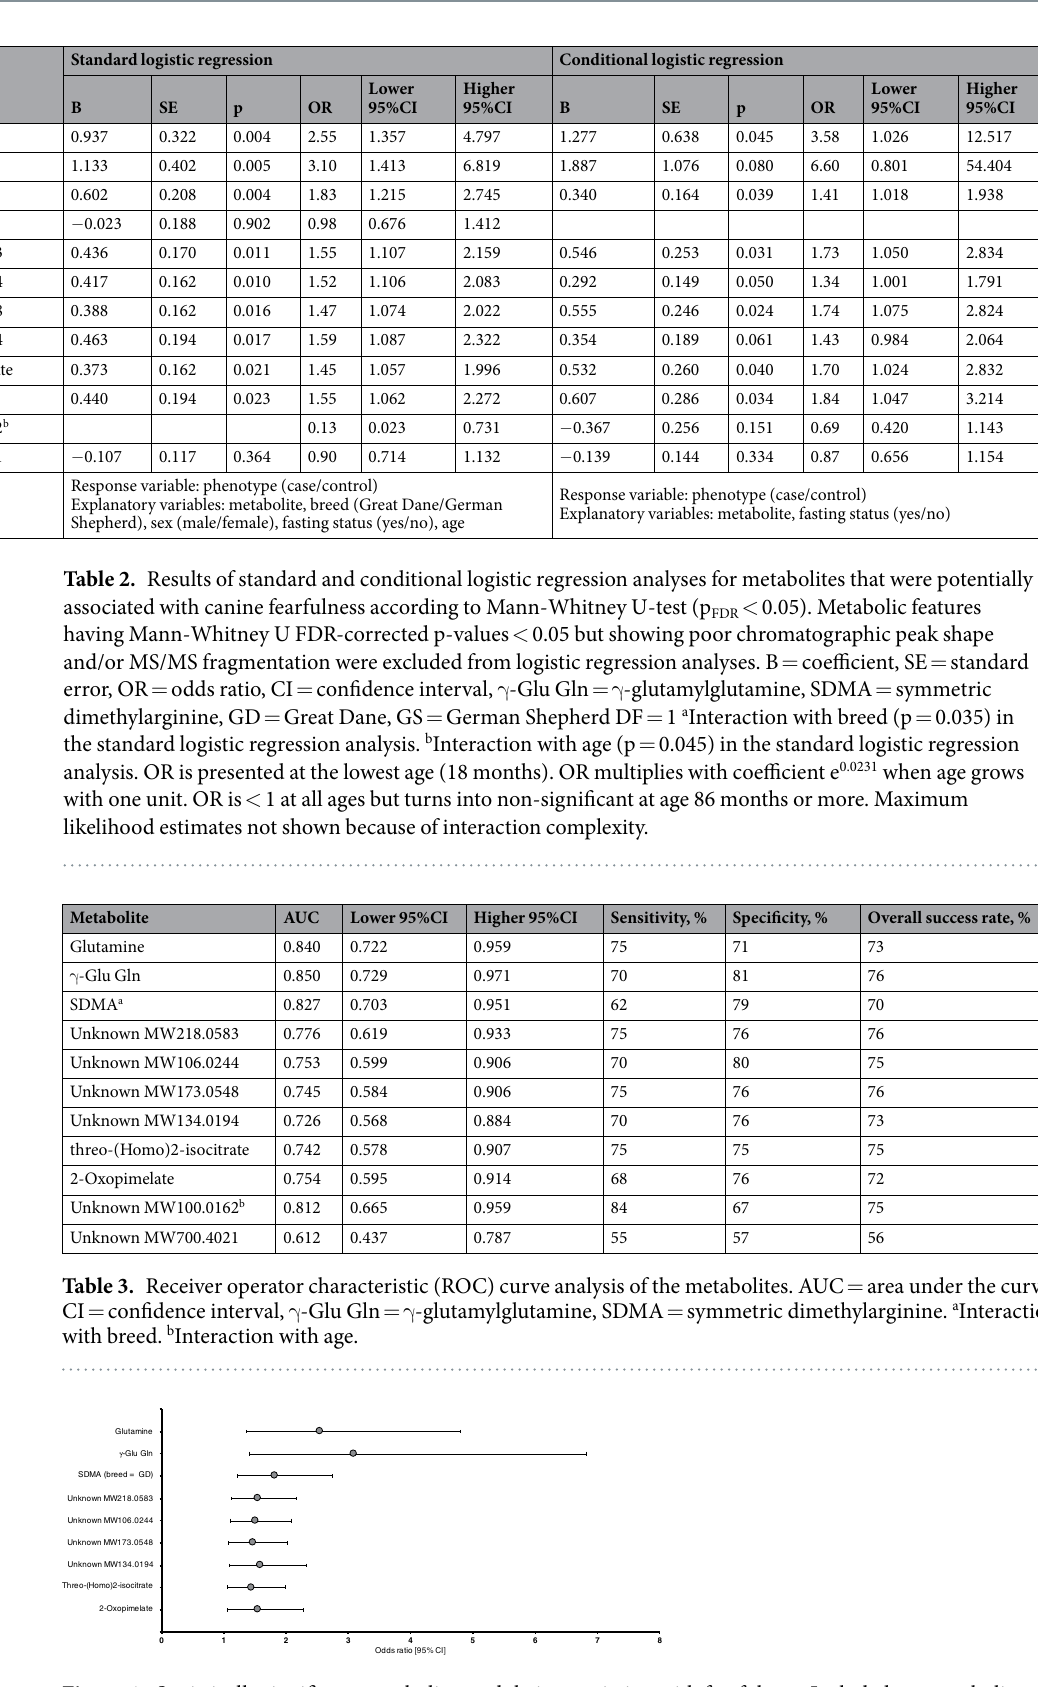
Figure 4. Statistically significant metabolites and their association with fearfulness. Included are metabolites that show statistical significance (p < 0.05) in standard logistic regression models. Error bars indicate 95% confidence limits. γ -Glu Gln, γ -glutamylglutamine; SDMA, symmetric